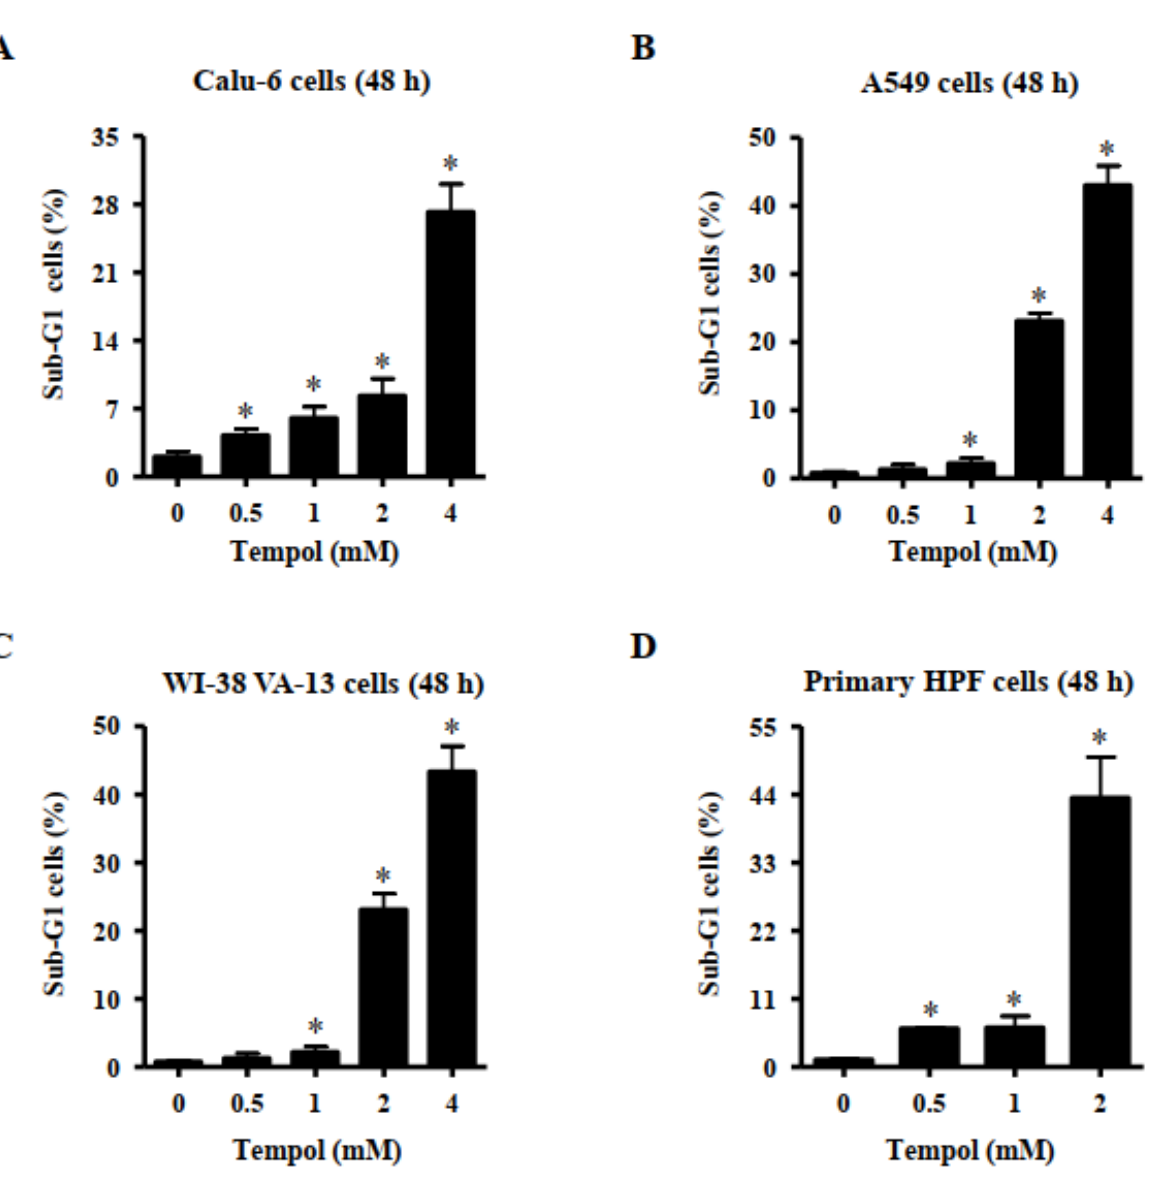
Figure 2. Effects of Tempol on sub-G1 cells of normal and lung cancer cells. Cells in exponential growth phase were incubated with Tempol at indicated concentrations for 48 h. Cells in sub-G1 phase were measured with a FACStar flow cytometer. Graphs show proportions of sub-G1 cells in Calu-6 cells ( A ), A549 cells ( B ), WI-38 VA-13 cells ( C ), and primary HPF cells ( D ). Student’s t -test was used. * p < 0.05 compared to Tempol-untreated control cells.